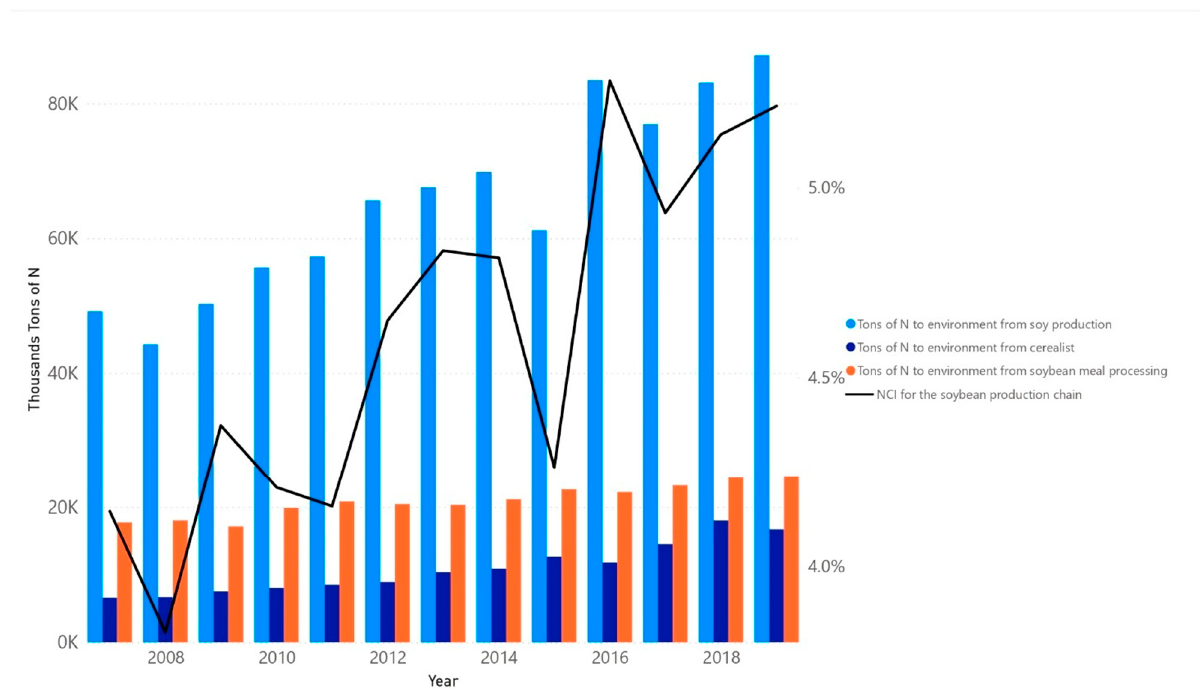
Figure 3. Nitrogen emissions directed to environment and Nitrogen Cascade Indicator (NCI) for soybean production chain in Brazil, 2007 to